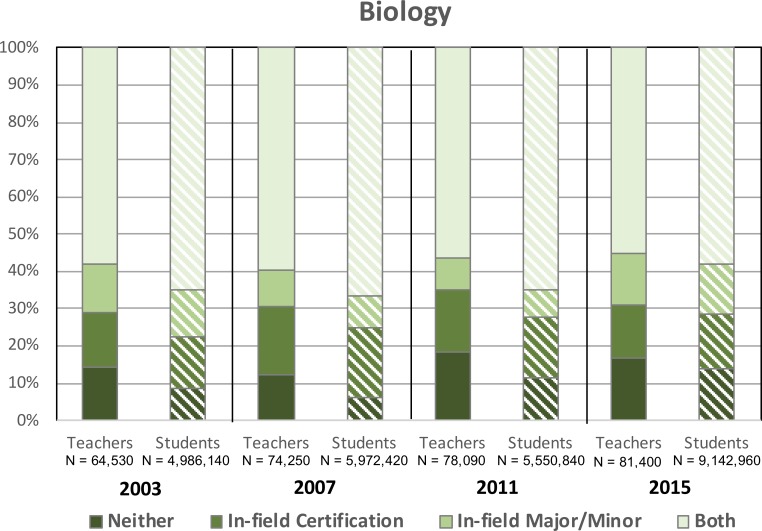
Percentages of in-field and out-of-field high school biology teachers and high school biology students assigned to these educators from 2003–2015.CV teachers < .008; CV students < .002; SEteachers ≤ 5%; SEstudents ≤ 2%.